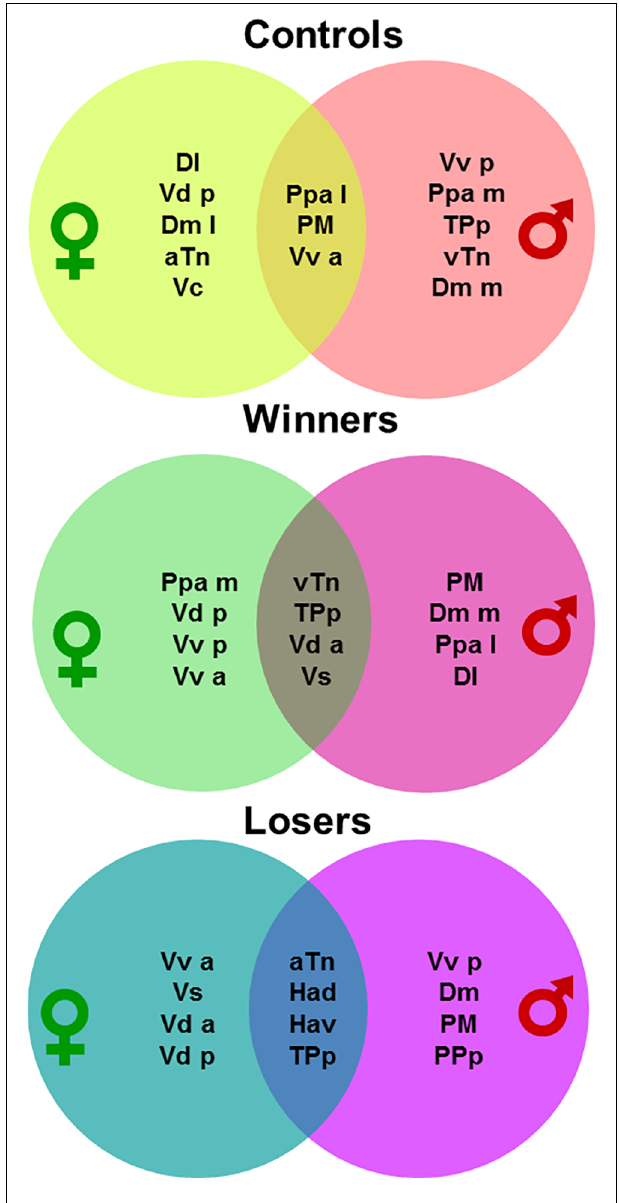
FIGURE 5 | Venn diagrams representing the most central nodes of the brain social decision-making network in males and females for each social treatment (i.e., non-interacting control, winners, losers). For brain region abbreviations please see the “Materials and Methods”